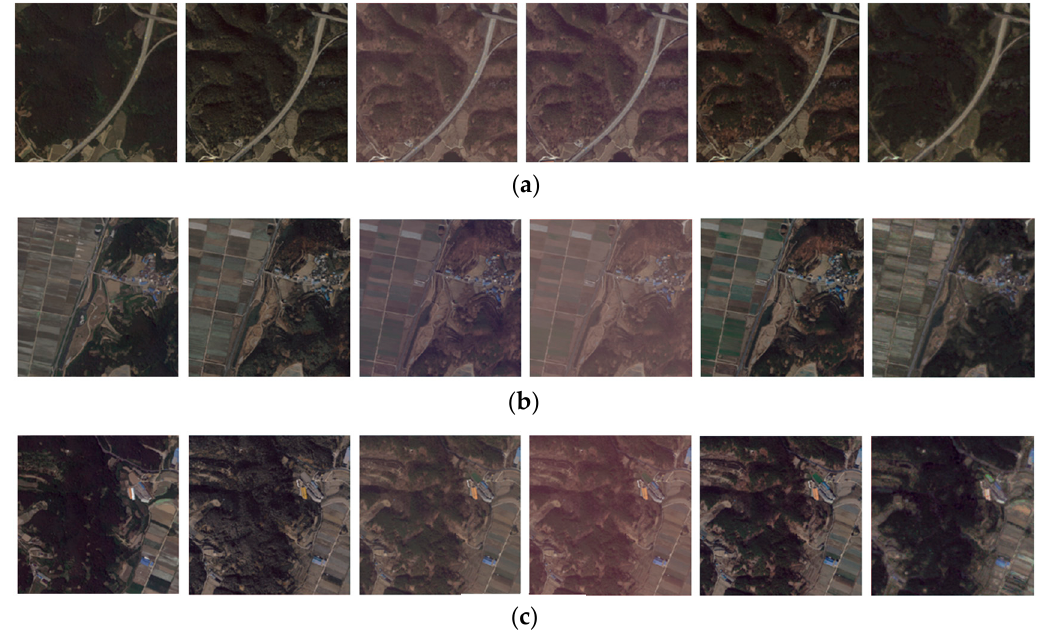
Figure 10. Enlargement of the vegetation area marked with a green rectangle: ( a ) site 1, ( b ) site 2, ( c ) site 3. From left to right: reference image, proposed method, MS, NC, histogram matching, and RF.